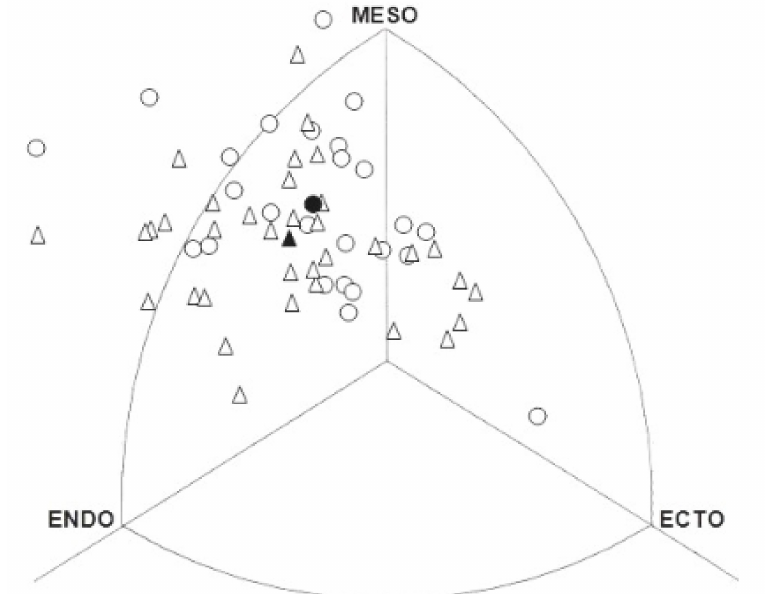
Figure 1. Somatotype distribution of elite ( • : Mean somatotype = 3.7–5.7–2.0; and subelite ( (cid:78) : Mean somatotype = 4.3–5.3–2.1; ∆ : Individual somatotype) padel players. MESO: mesomorphy; ECTO: ectomorphy; ENDO: